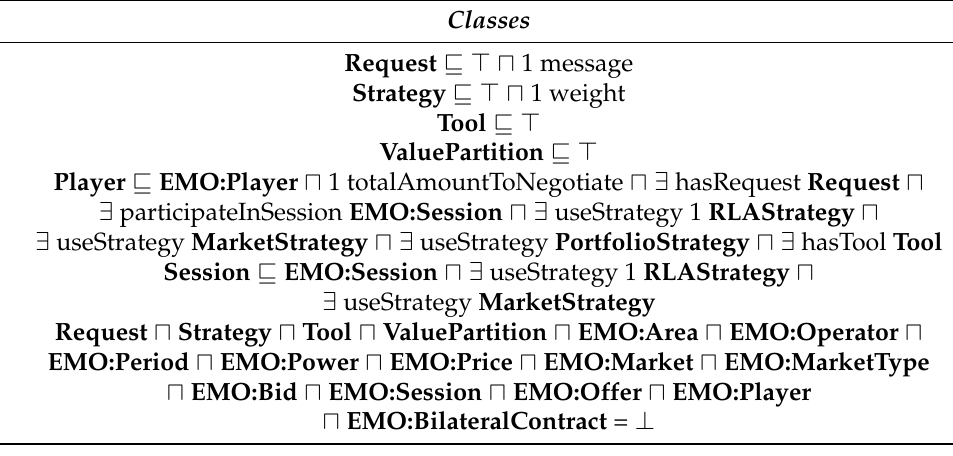
Table 3. AiD-EM Ontology root classes in DL syntax.